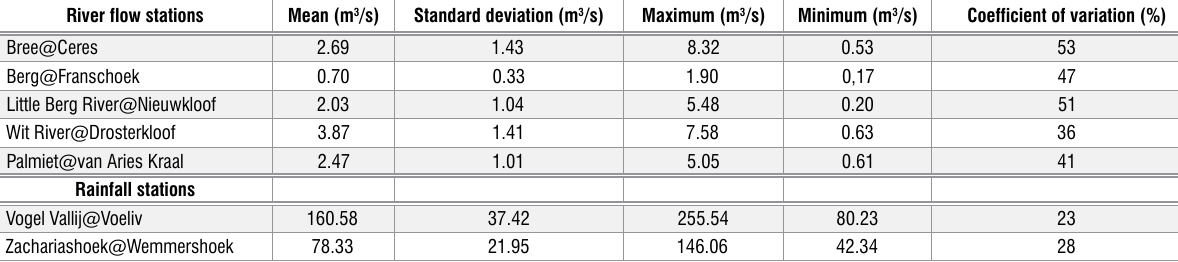
Descriptive statistics of annual river flow and rainfall stations River flow